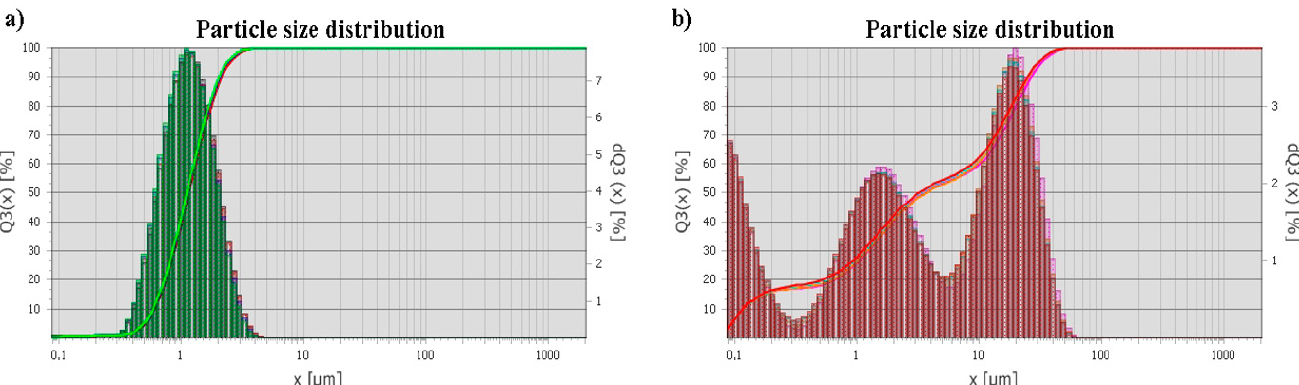
Figure 3. Particle size distribution of F-BaTiO 3 ( a ) and C-BaTiO 3 ( b ).